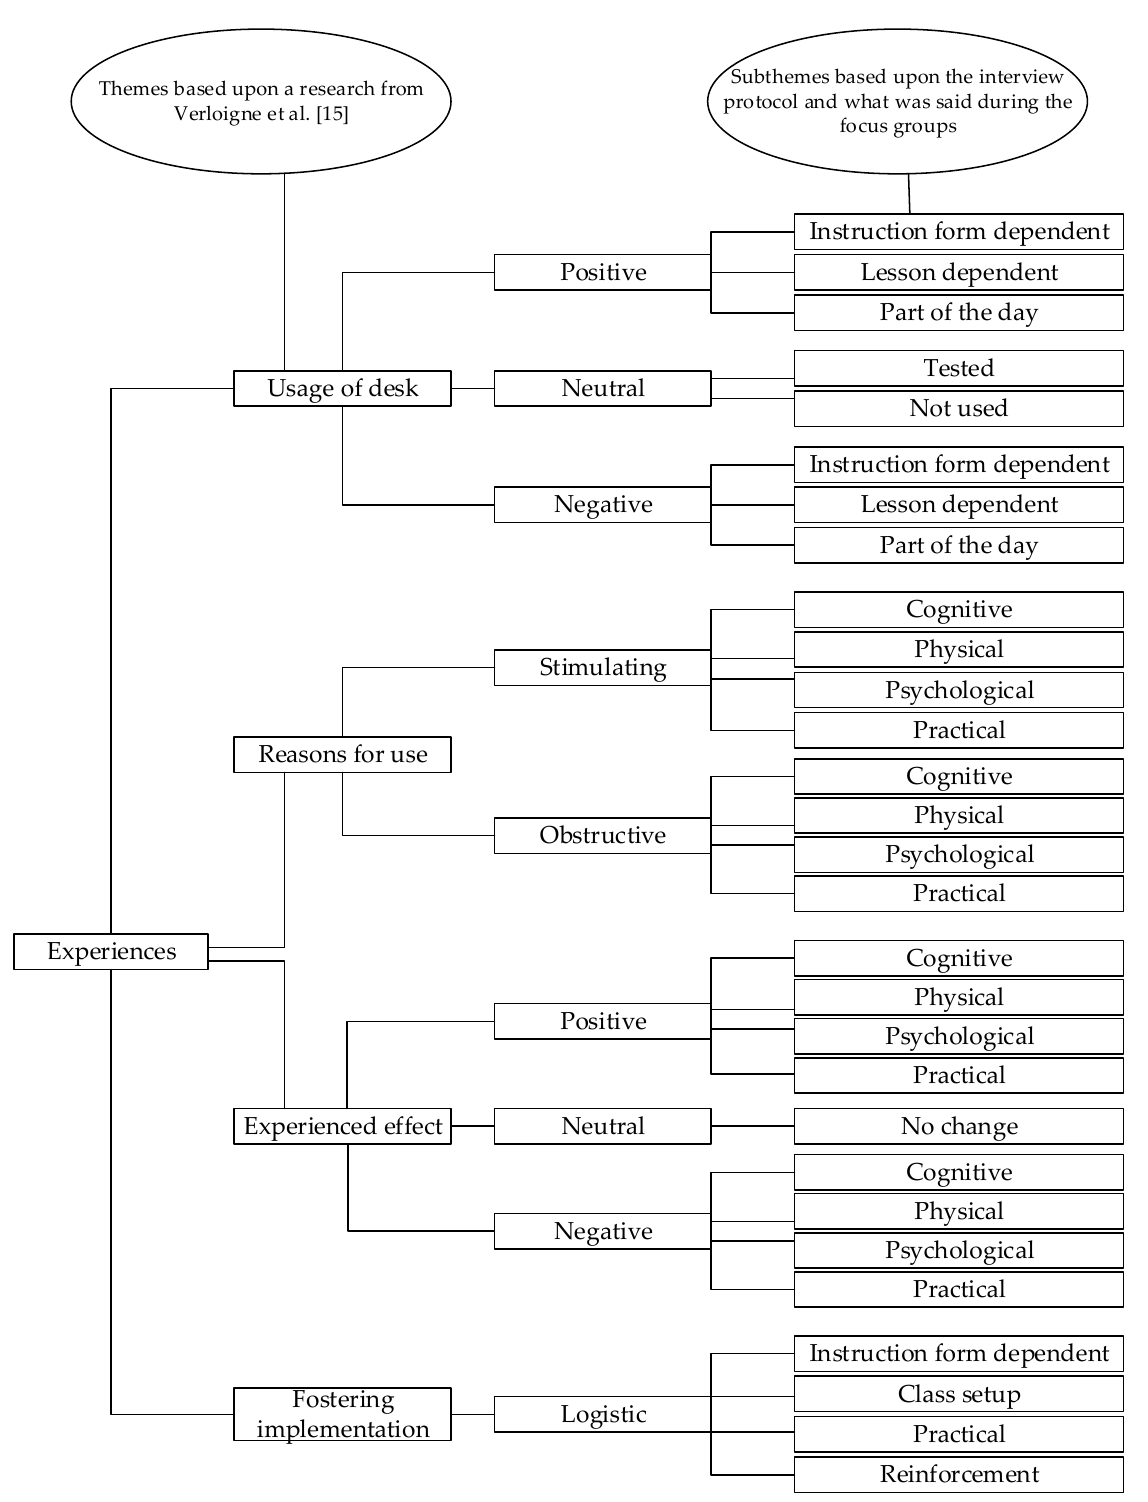
Figure 1. Coding scheme for evaluating the interview transcripts.